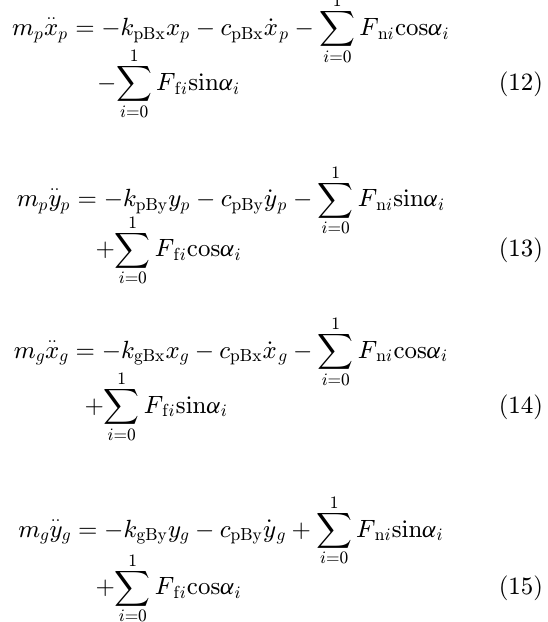
Fig. 4. 6-DOF dynamics model of gear drive with curved path of